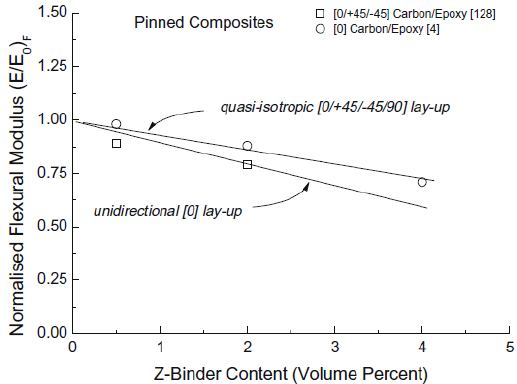
Figure 50. E ff ect of z-Pin content on flexural modulus due to z-Pinning on various lay-up laminates (CFRP z-Pins, pre-preg) [15].